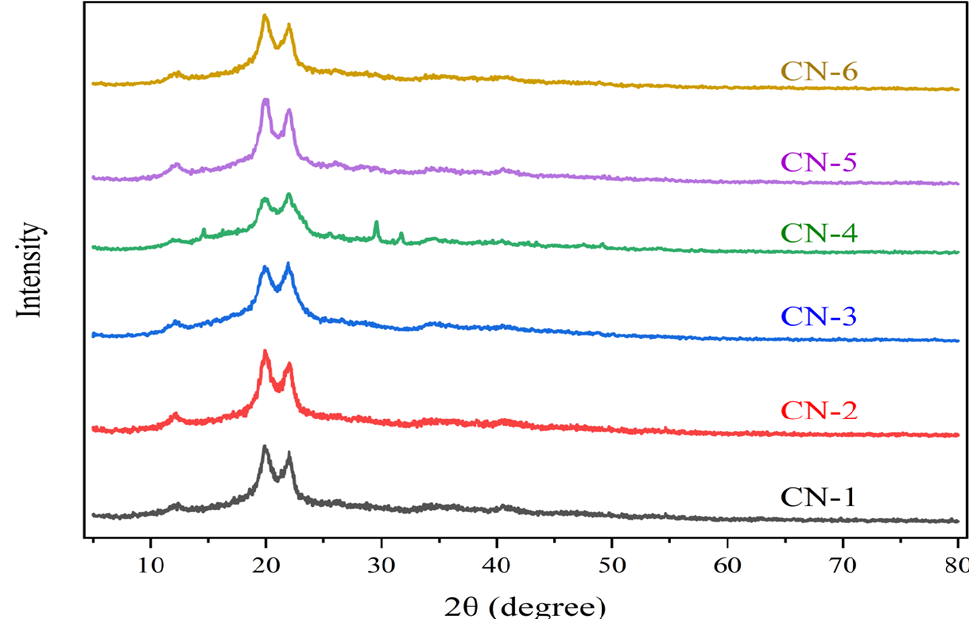
Figure 6. XRD patterns of jute cellulose nanocrystals of CN-1, CN-2, CN-3, CN-4, CN-5, and CN-6.